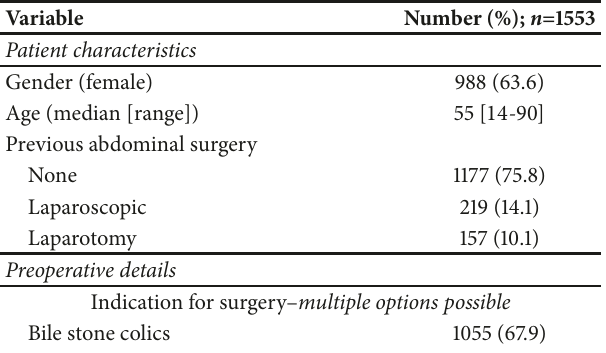
Table 1: Patient clinicopathologic and operative